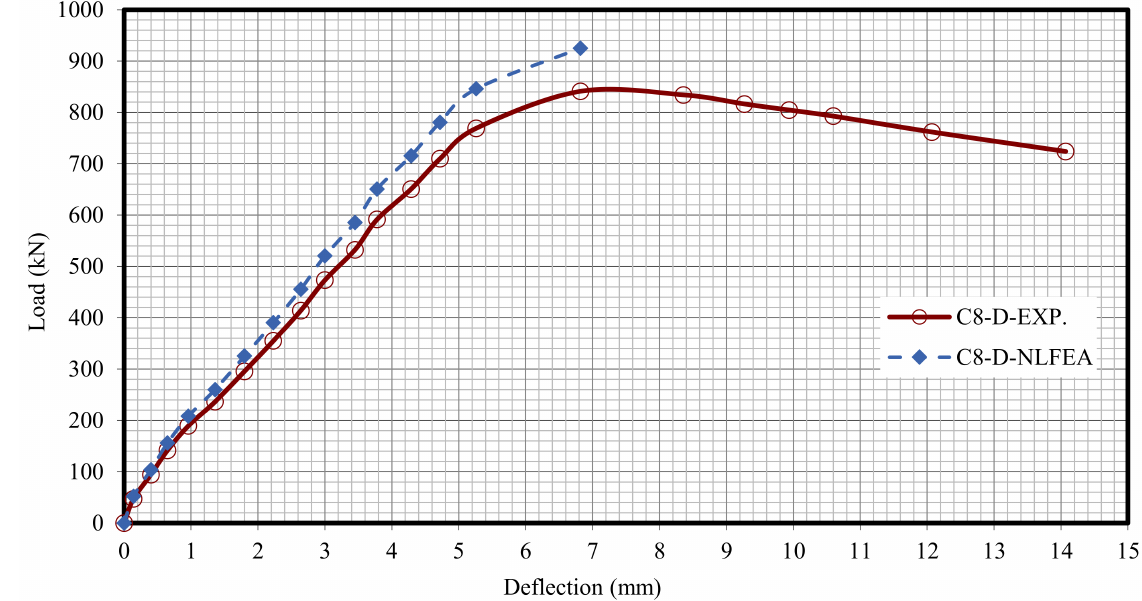
Figure 29. Load deflection of Column C8-D.